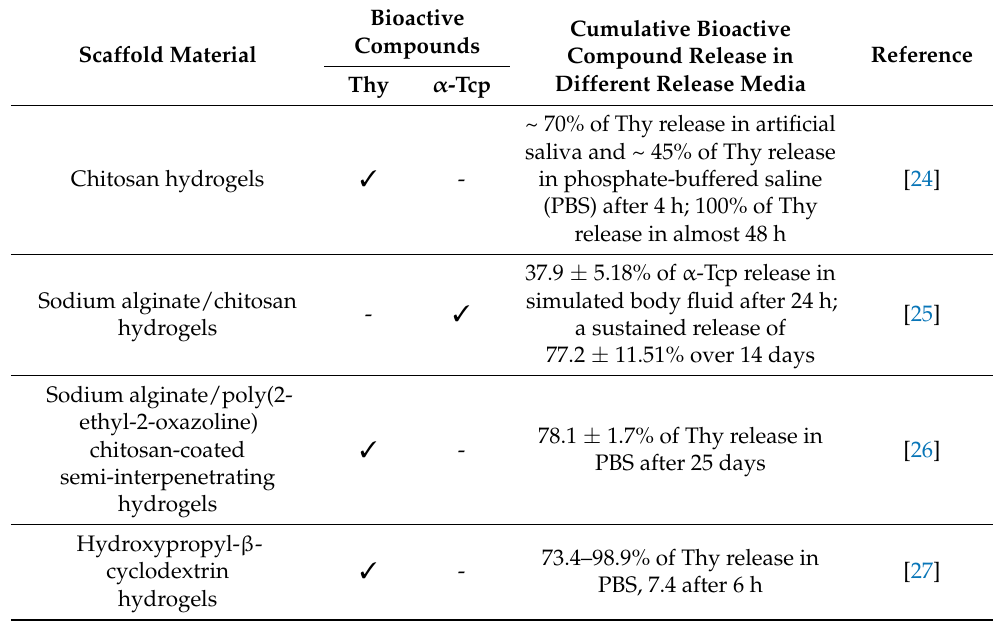
Table 1. A summary of controlled release studies of bioactive compounds from